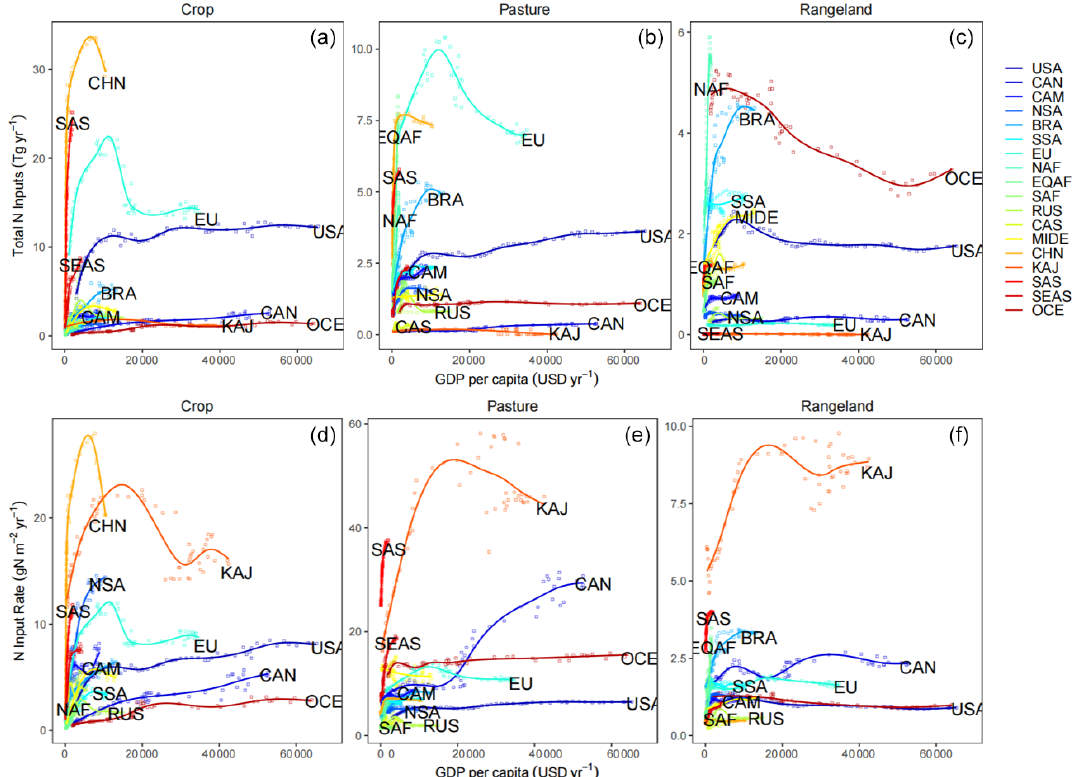
Figure 12. Relationships between total N inputs (excluding N deposition; a–c ) or the N input rate ( d–f ) and GDP per capita on cropland, pasture, and rangeland, respectively, within each of 18 regions during the period from 1961 to 2019. The lines were fitted using the generalized additive models. For visual clarity, not all region names are shown in each panel. The 18 regions are as follows: the USA (USA), Canada (CAN), Central America (CAM), northern South America (NSA), Brazil (BRA), southwestern South America (SSA), Europe (EU), Northern Africa (NAF), Equatorial Africa (EQAF), Southern Africa (SAF), Russia (RUS), Central Asia (CAS), the Middle East (MIDE), China (CHN), Korea and Japan (KAJ), South Asia (SAS), Southeast Asia (SEAS), and Oceania